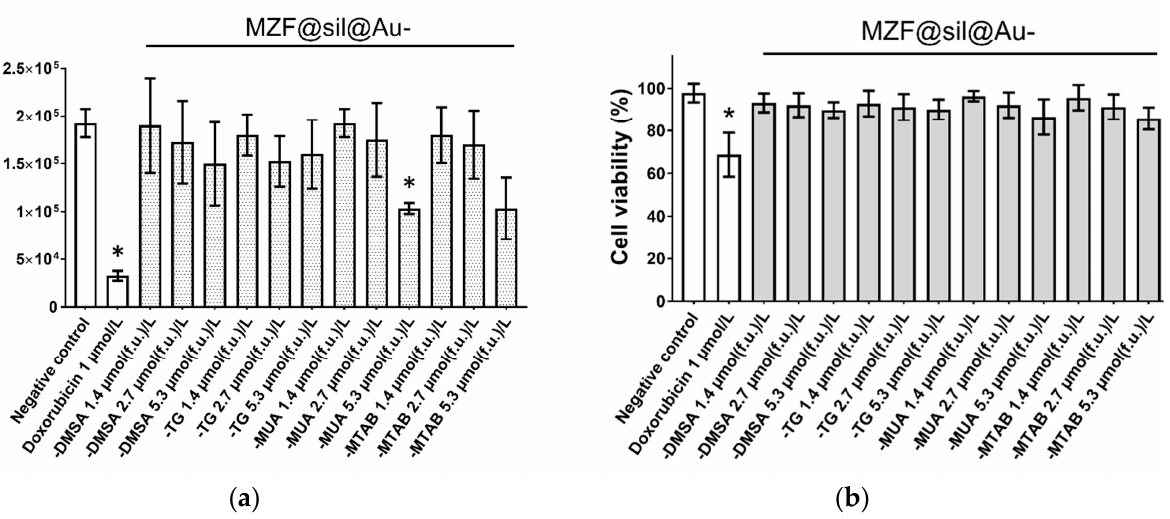
Figure 7. The effect of MZF@sil@Au-DMSA, MZF@sil@Au-TG, MZF@sil@Au-MUA, or MZF@sil@Au- MTAB on the ( a ) proliferation and ( b ) viability of MCF-7 cells. Changes in the proliferation and viability were monitored using the trypan blue exclusion test 48 h after the treatment. Results